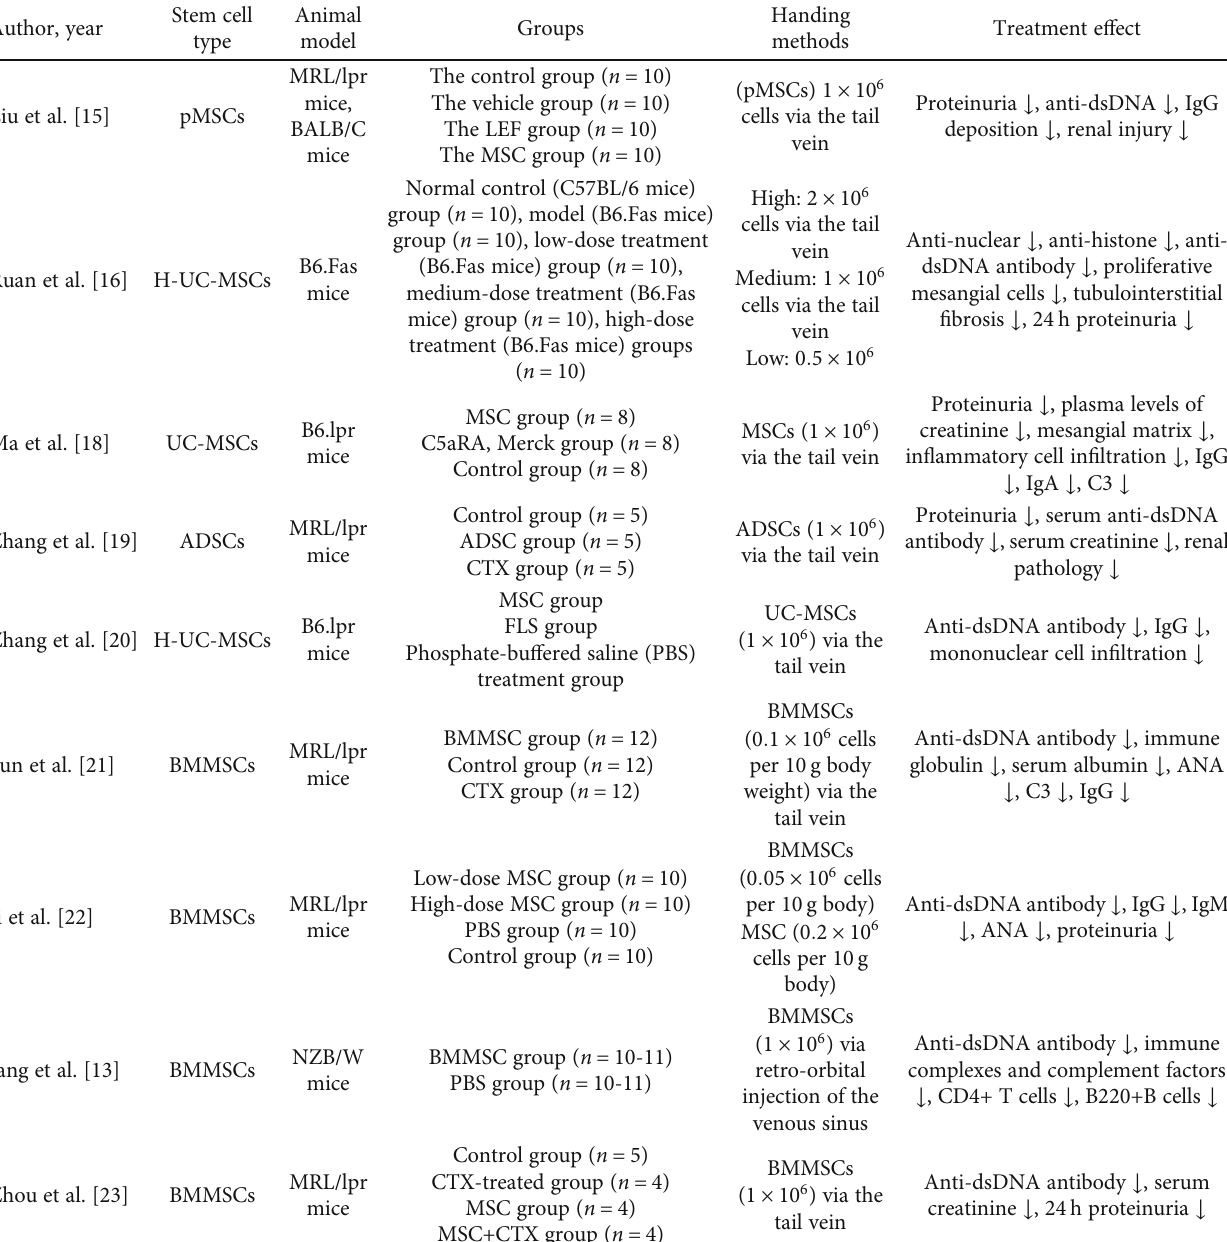
Table 1: E ffi cacy of MSC therapy in animal